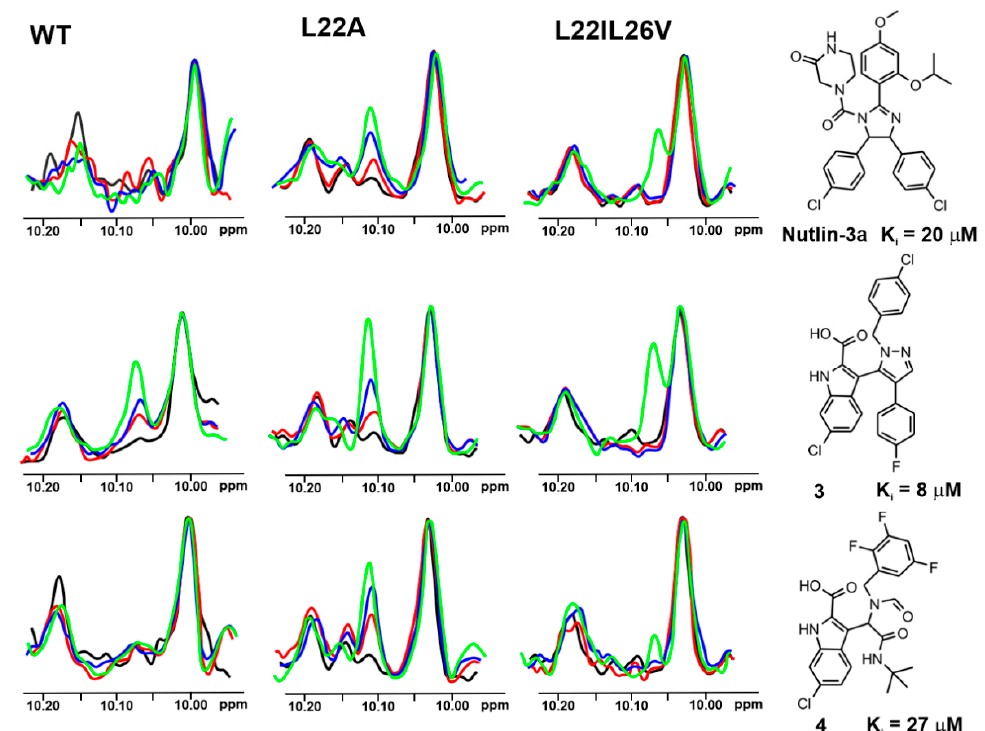
Figure 3. The 1D AIDA proton NMR spectra of the side chain N H ε proton of tryptophans for the mutant-p53 / MdmX complexes (p53-wt, L22A, and L22IL26V). All protein complexes (black) were treated with Nutlin-3a, compound 3 and 4 in molar ratio: the protein to a compound 1:1 (red), 1:2 (blue), and 1:5 (green), respectively.